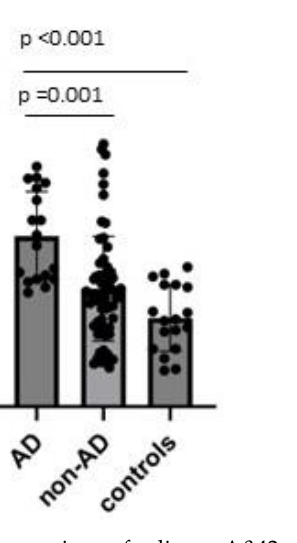
Figure 2. Comparison of salivary A β 42 concentrations between AD, non-AD, and controls. Data were shown as mean ± SD.